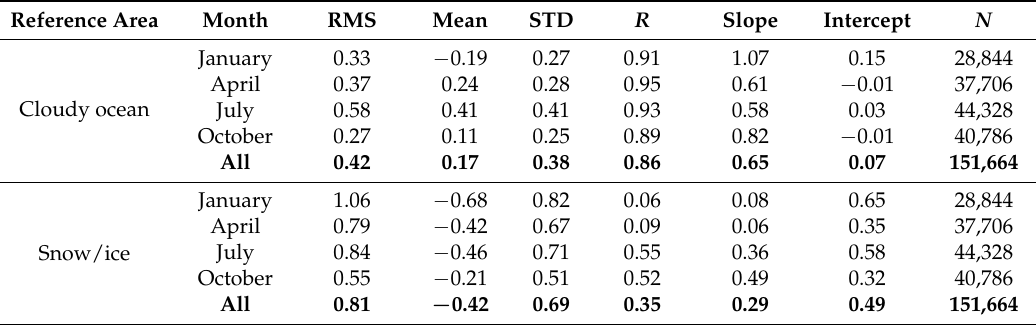
Table 5. Similar to Table 3 but for tests with different reference spectra. Reference spectra for the PC analysis from cloudy ocean or snow/ice-covered areas are compared to desert areas (baseline). All correlations are highly